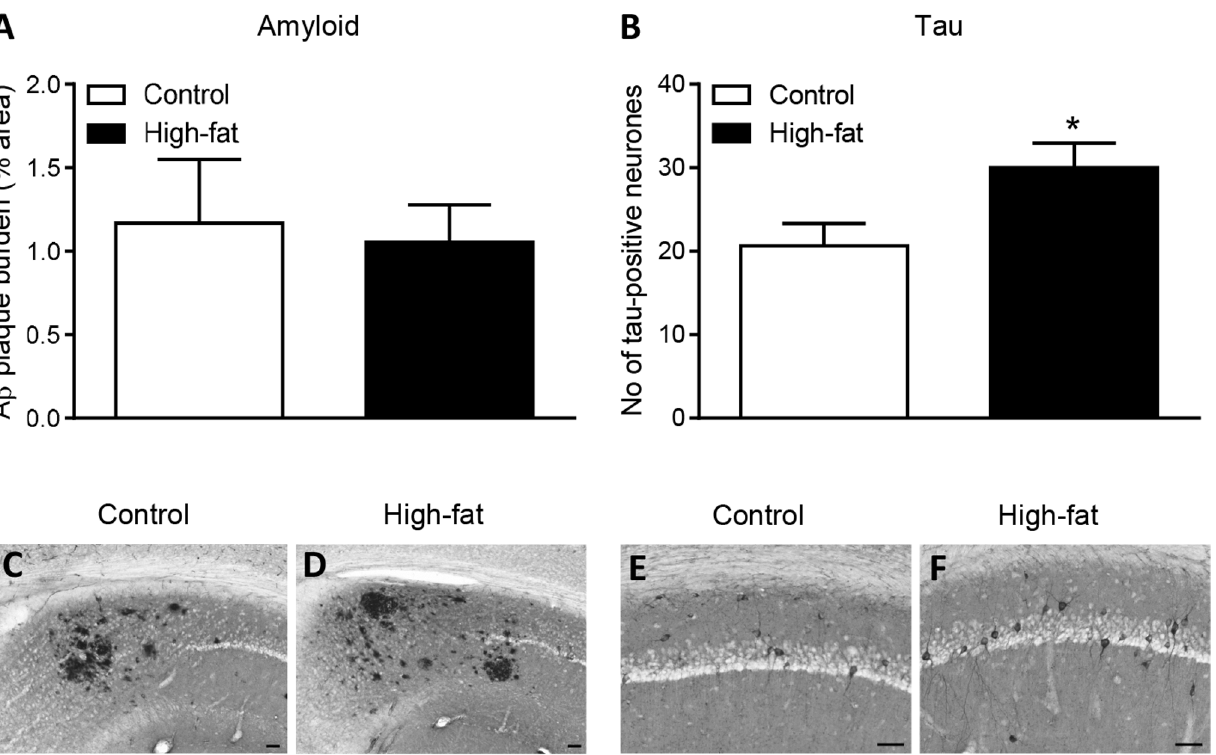
Figure 5. A high-fat diet during pregnancy and lactation increases tau pathology in the hippocampus of female 3xTgAD offspring mice at 12 months of age. The A b extracelluar plaque burden (A) and the number of hyperphosphorylated tau-positive neurones/section (B) were assessed in the hippocampus of female offspring mice from dams fed a control or high-fat diet during pregnancy and lactation. Data are mean 6 SEM for n =5 per group. * P , 0.05. C-F are representative photomicrographs in the hippocampus of A b plaques (C–D) and hyperphosphorylated tau (E–F) detected by immunohistochemistry using 6E10 and AT8 antibodies, respectively. Scale bars: 100 m m.